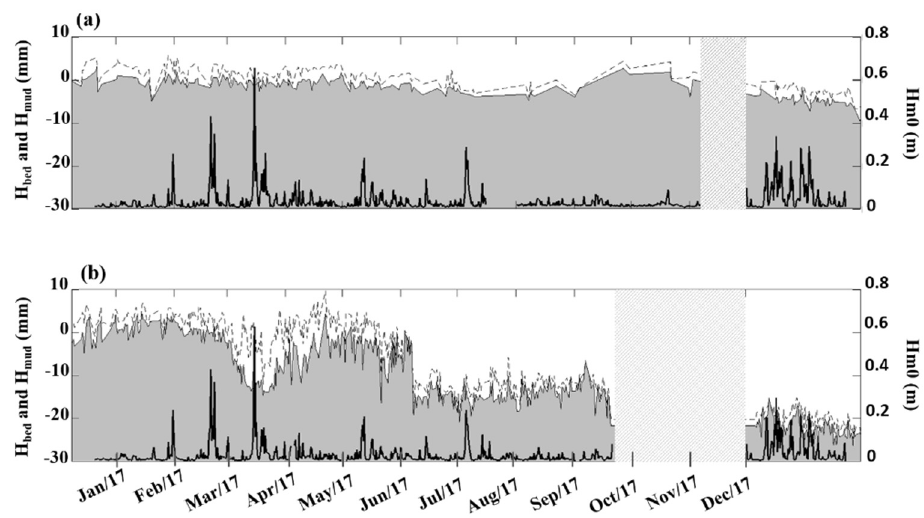
Figure 6. Consolidated bed level (solid grey surface) and soft mud level (dashed black line) and corresponding mean wave height (black line) within the vegetation patches of ( a ) Spartina anglica and ( b ) Spartina maritima . Dashed grey box indicates “no data” period.